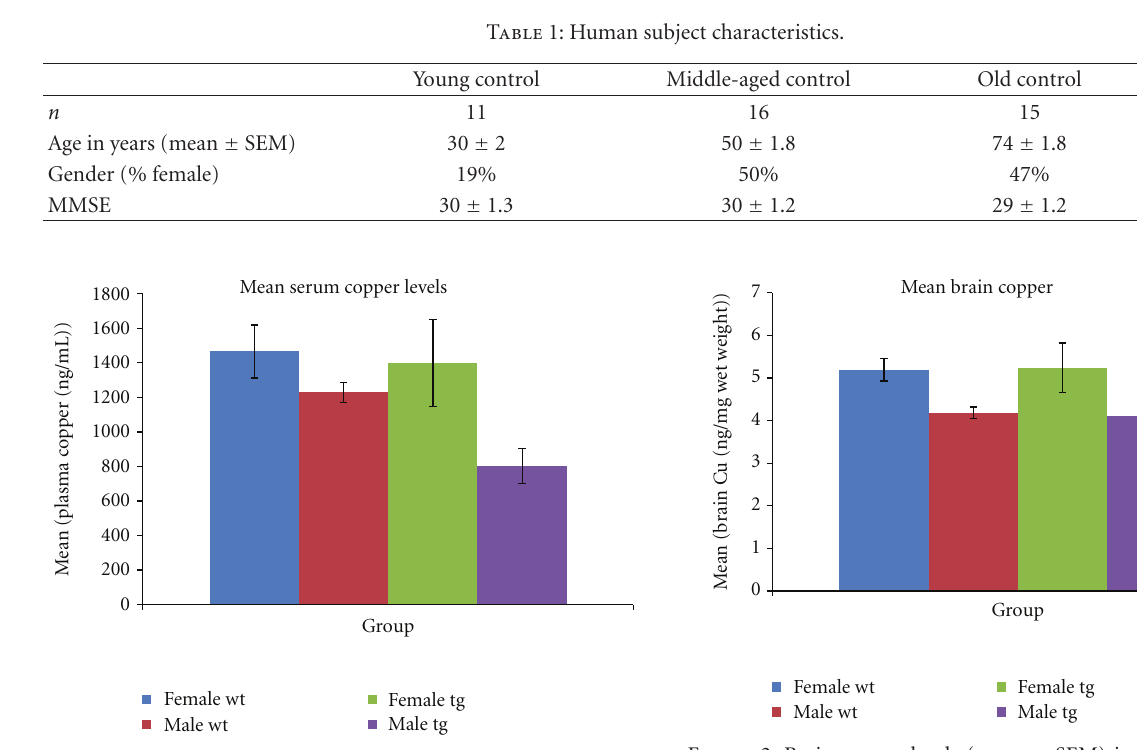
Figure 2: Brain copper levels (mean ± SEM) in triple transgenic (tg) and wild-type (wt) mice. Brain copper is significantly higher in female wt compared to male wt mice ( P = 0 . 03), and a trend to higher brain copper in female tg compared to male tg mice is also evident ( P = 0 .